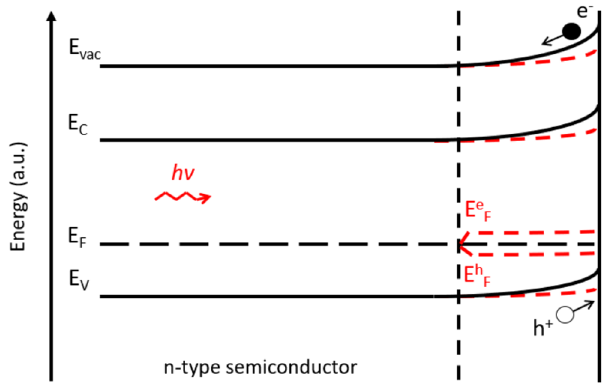
Fig. 8. Representation of the energy bands pro fi le in a n-type semiconductor in dark conditions and under illumination depicted by black solid lines and red dashed lines, respectively. E e E h fi les for the quasi-Fermi levels F and F represent possible pro for electron and holes,